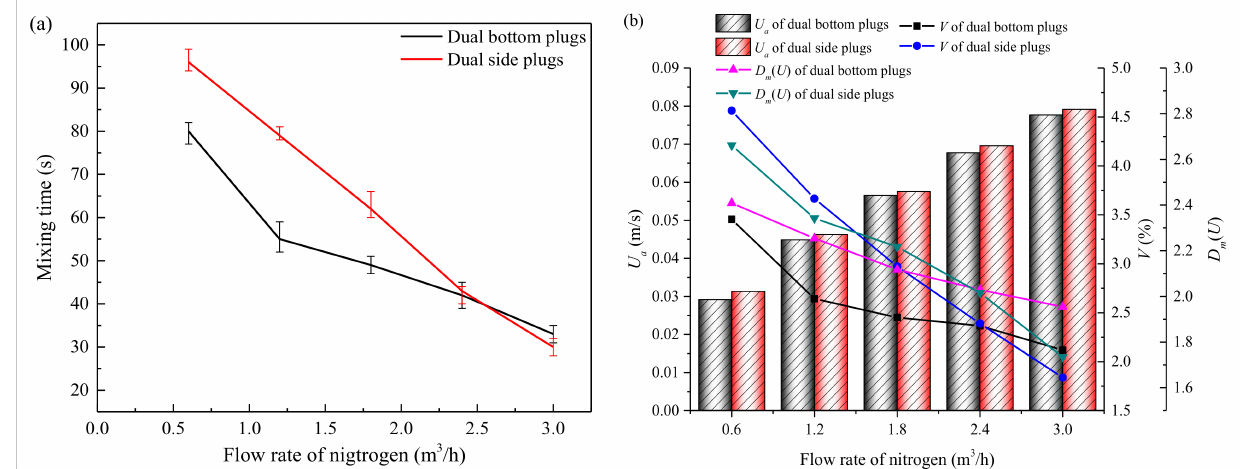
Figure 8. Mixing time and flow parameters of water in model ladle under two blowing modes: ( a ) mixing time; ( b ) flow parameters of water.